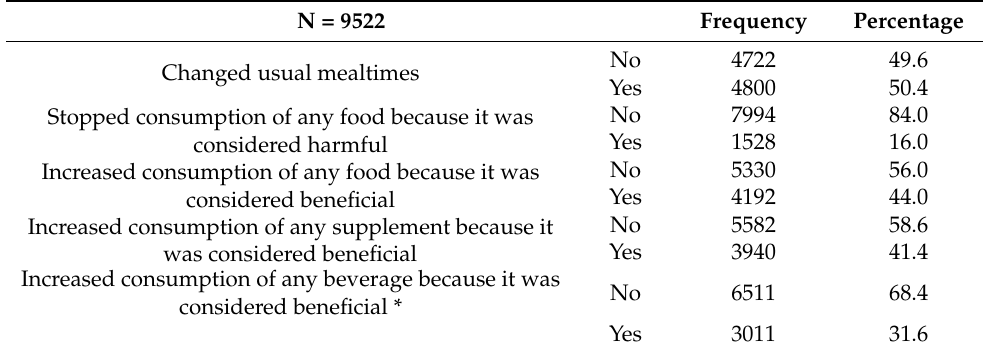
Table 3. Eating habits, nutritional supplements and beverages intake; total